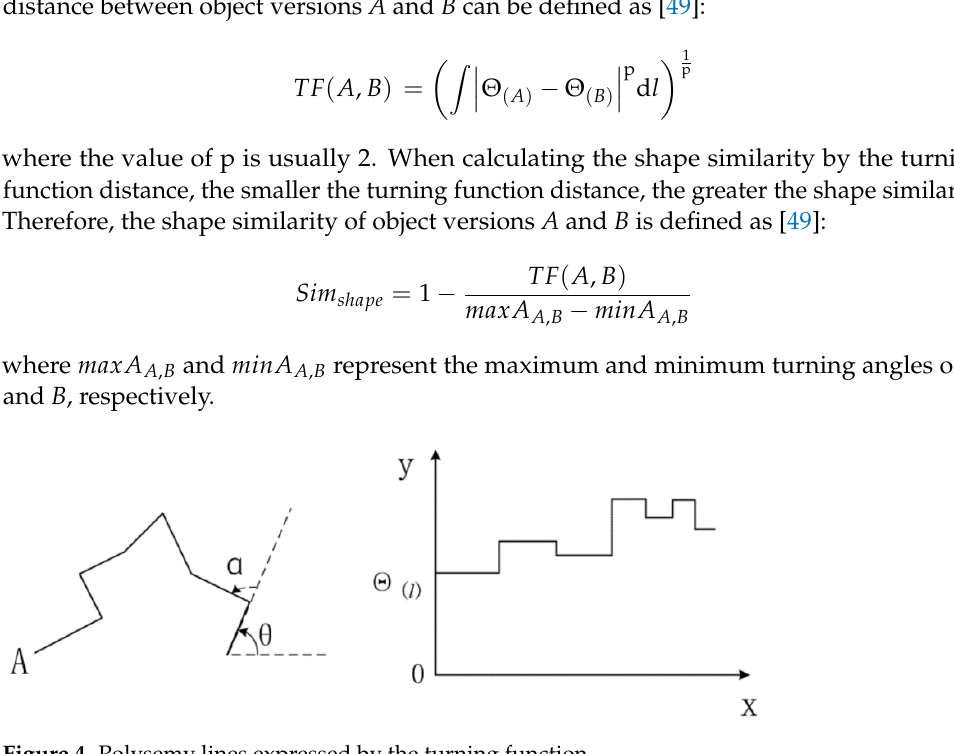
Figure 4. Polysemy lines expressed by the turning function.